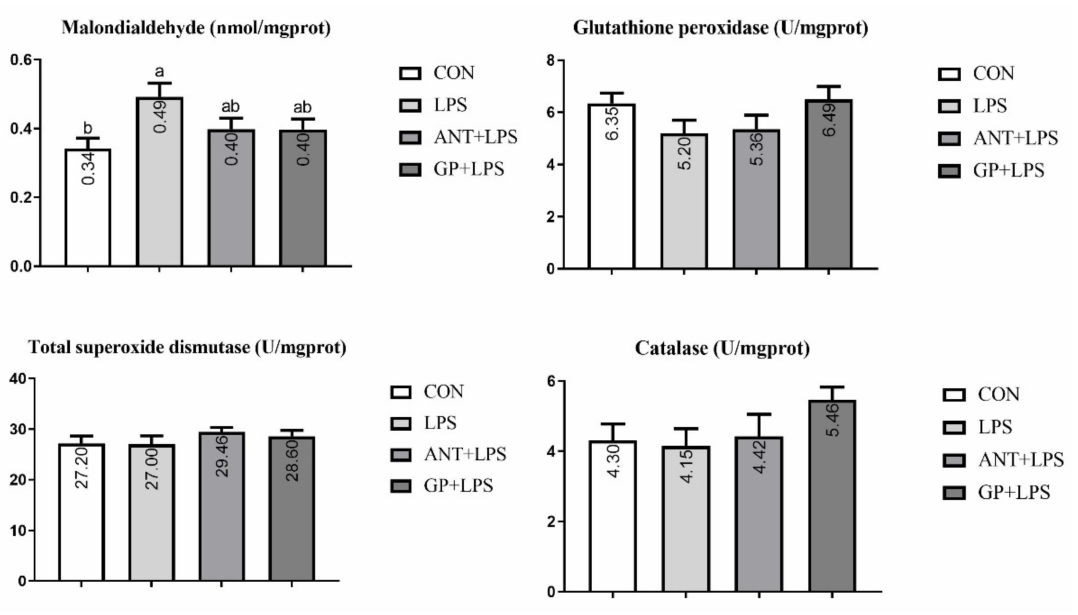
Figure 5. Effects of dietary garlic powder inclusion on antioxidant function of jejunum mucosa in broilers challenged with lipopolysaccharide (data were presented as mean and SEM, means that do not share the same superscript are significantly different, p < 0.05).